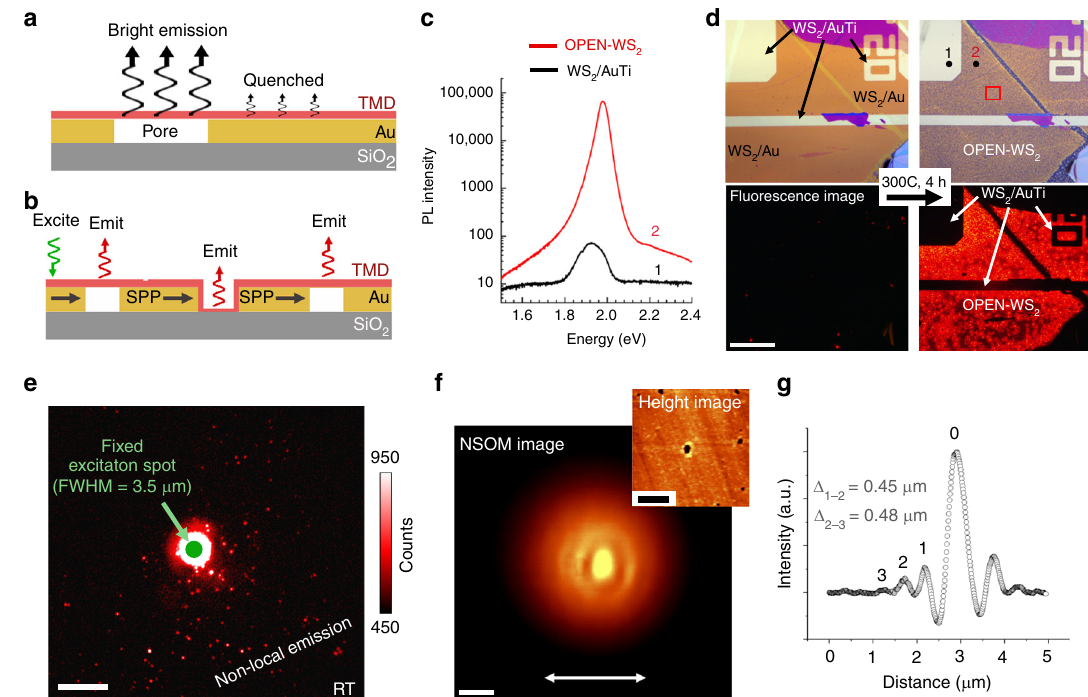
Fig. 3 Optical characterization of OPEN-WS 2 samples. Cartoon illustrating a strong emission from the suspended TMD and quenched emission where it is supported by Au and b remote excitation and emission from the an OPEN-WS 2 fi lm. c PL spectra (log 10 intensity) taken from spot 1 and spot 2 in the optical image in d . d Optical and fl uorescence images (integrated CCD image) of a monolayer-WS 2 /Au/SiO 2 sample before and after annealing (red box = AFM region from Fig. 2a; scale bar = 50 μ m). Regions of Au-Ti were selectively patterned to inhibit dewetting at speci fi c locations. e Fluorescence image of an OPEN-WS 2 fi lm on Au with a fi xed excitation laser spot (beam FWHM ≈ 3.5 μ m, power = 4.5 mW, room temperature (RT)) demonstrating remote excitation of suspended WS 2 pixels (truncated intensity scale; scale bar = 10 μ m). f Topography and near- fi eld scanning optical microscopy (NSOM) interference pattern originating from SPPs (scale bar = 1 μ m; inset scale bar = 2 μ m; arrow shows polarization direction). g Horizontal cross-section of near- fi eld intensity taken from f